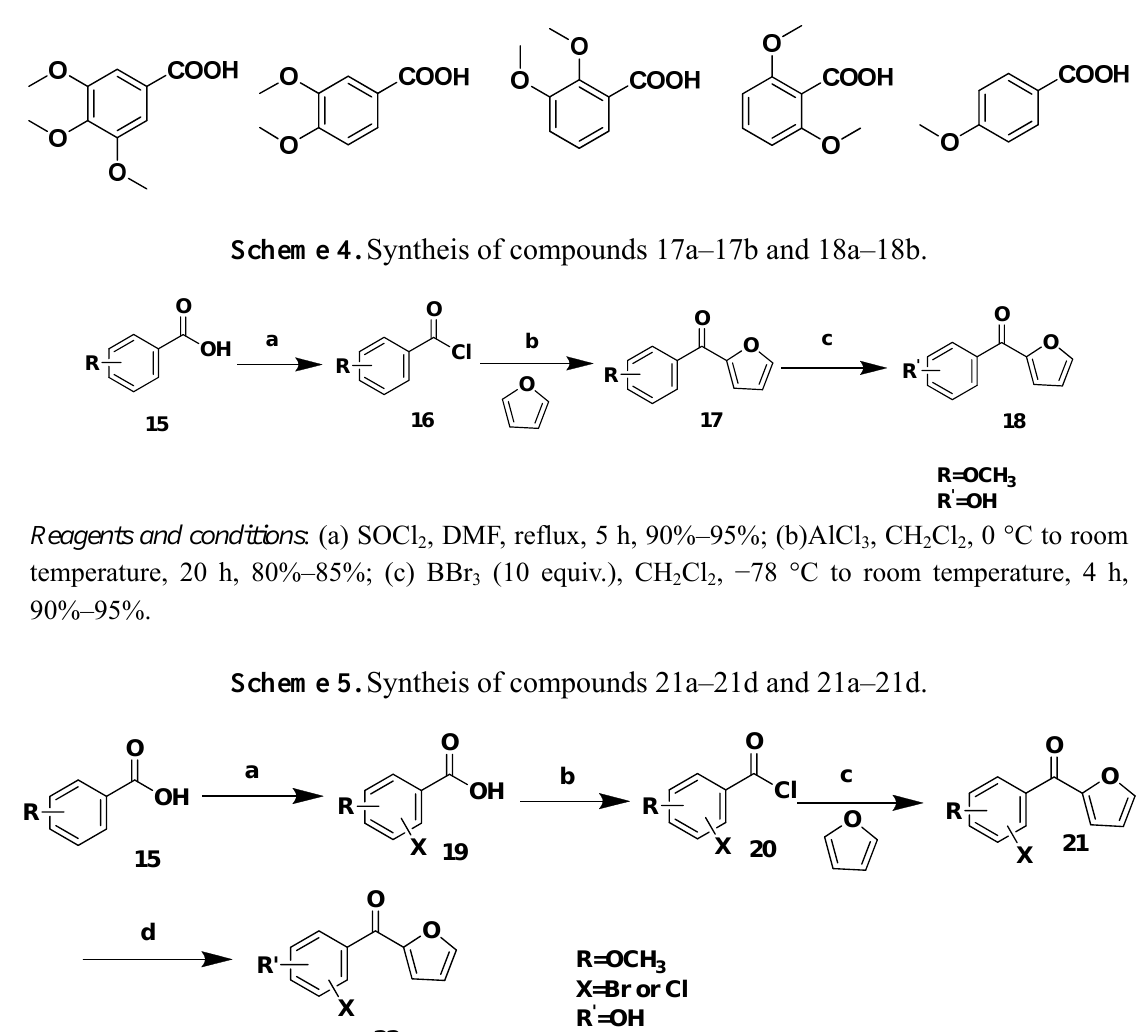
Figure 1. Structures of starting materials 15 .